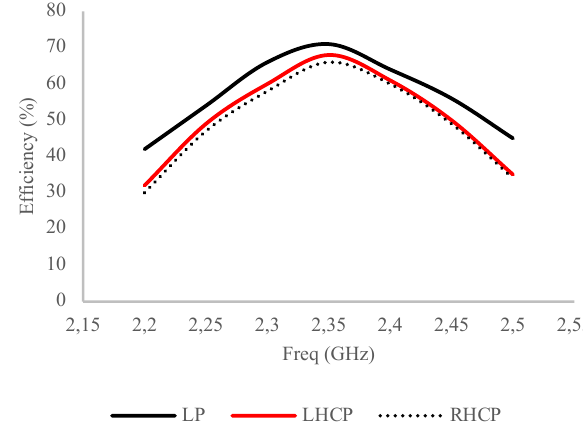
Figure 9: Measured antenna efficiency (%)